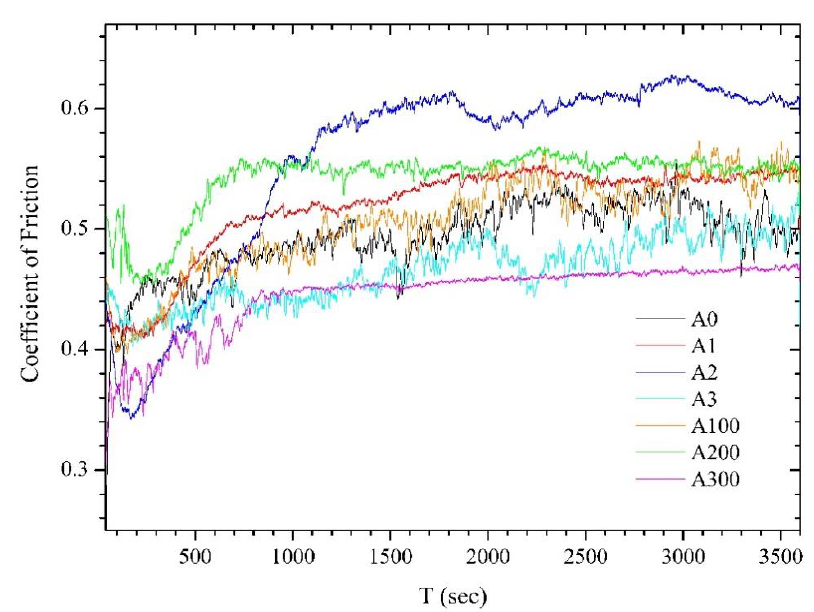
Figure 11. FC curves for the annealed samples (A1–A3) and RIE samples (A100–A300) at increasing normal load from 0 to 10 N for 1 h. A0 refers to the referent sample.